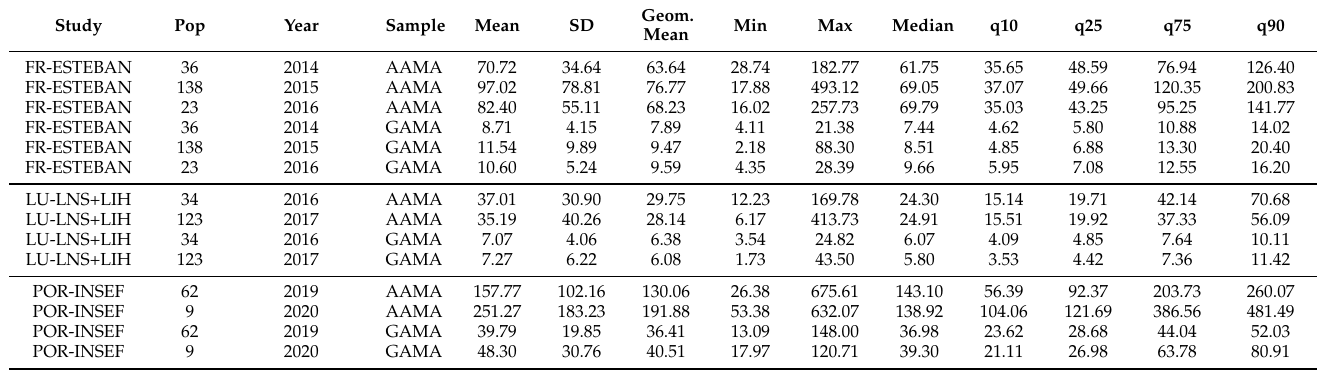
Table A8. Descriptive statistics of acrylamide biomarker levels per study and year (adults II).